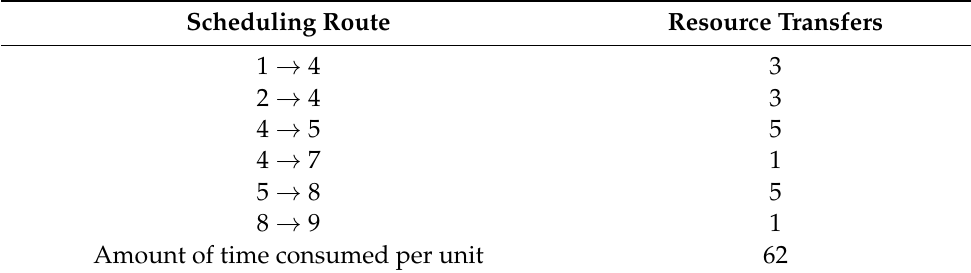
Table 5. RQRCS scheduling observation resource calculation results.